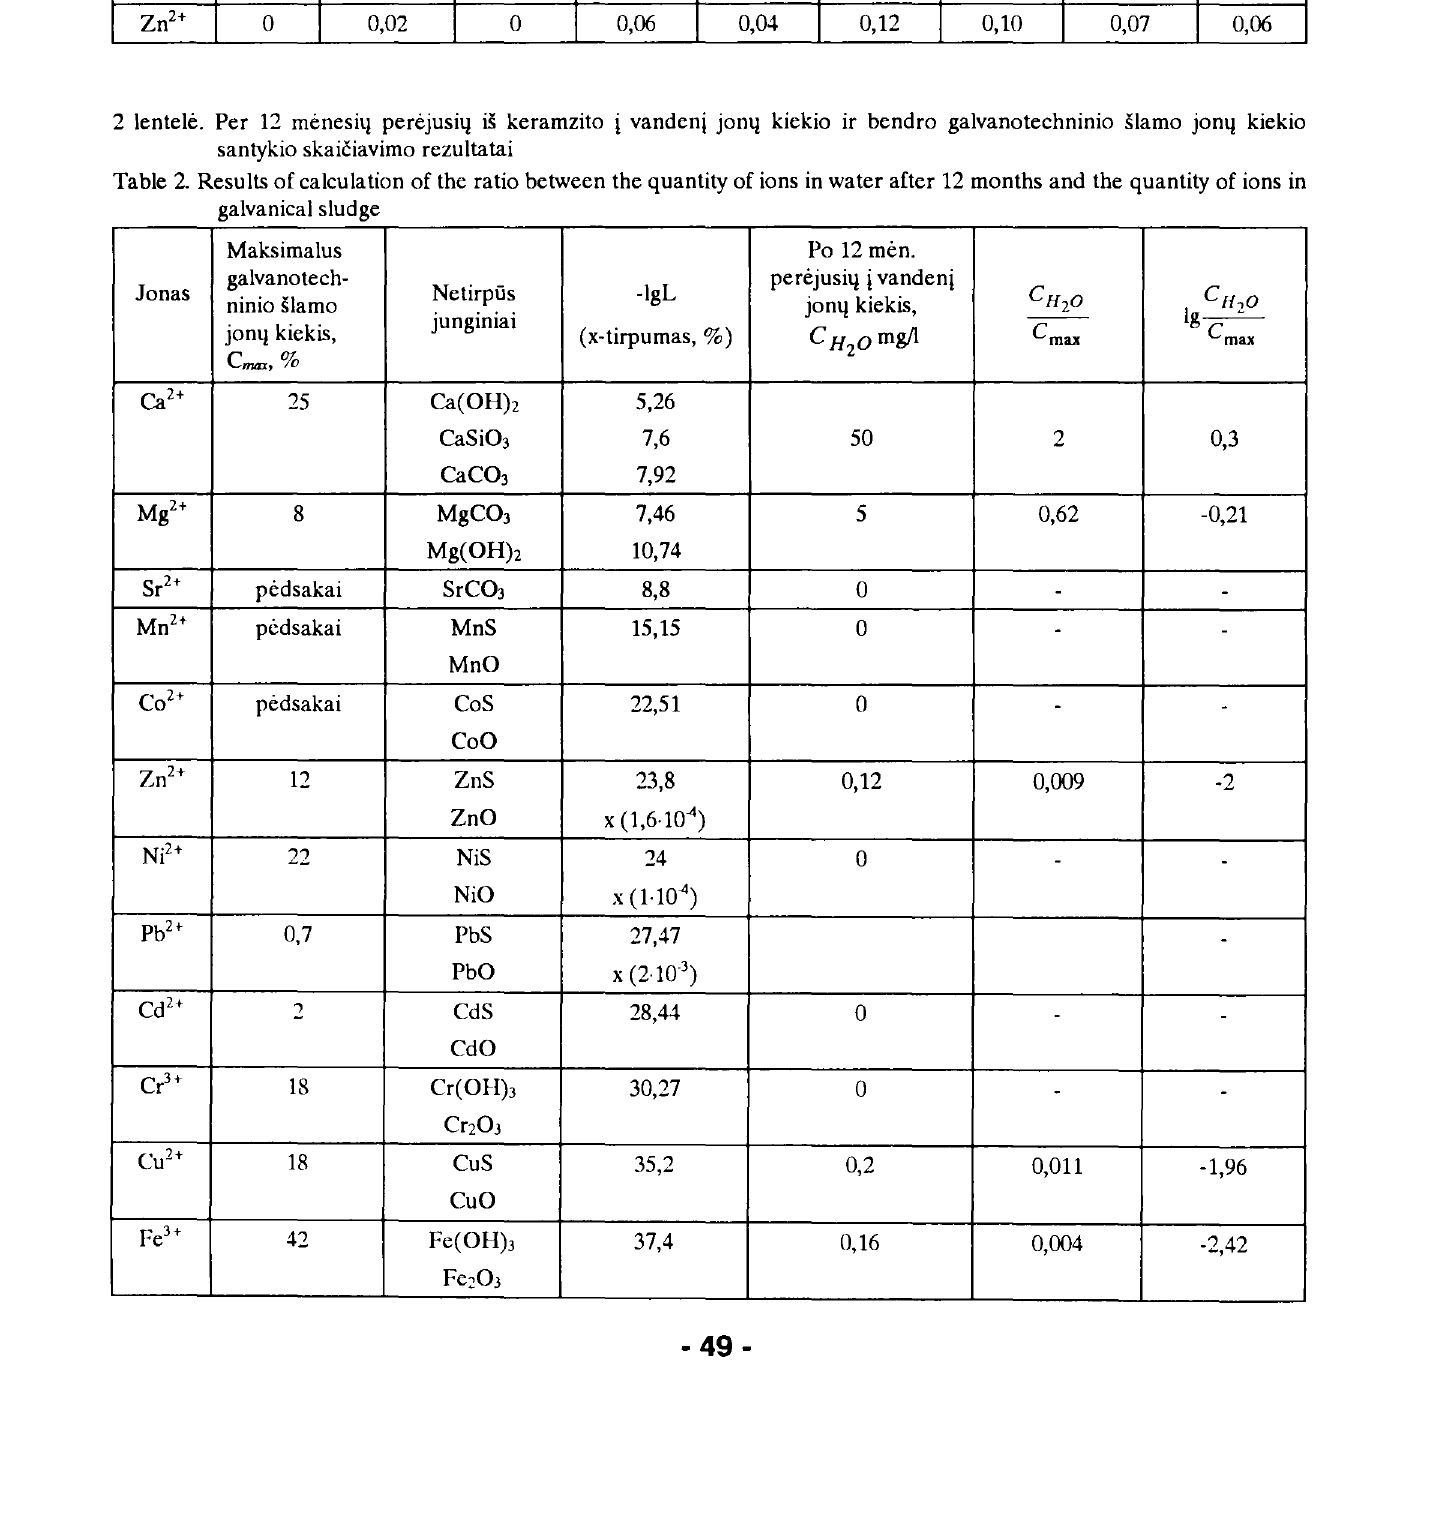
Table 1. Kinetics of washing - out of microelements in distilled water at room temperature out of the galvanotechnical slime- containing ceramzite produced by "Palemonas" factory Jon4 kiekiai vandenyje, mgll Jonai po 3 menesi'-1